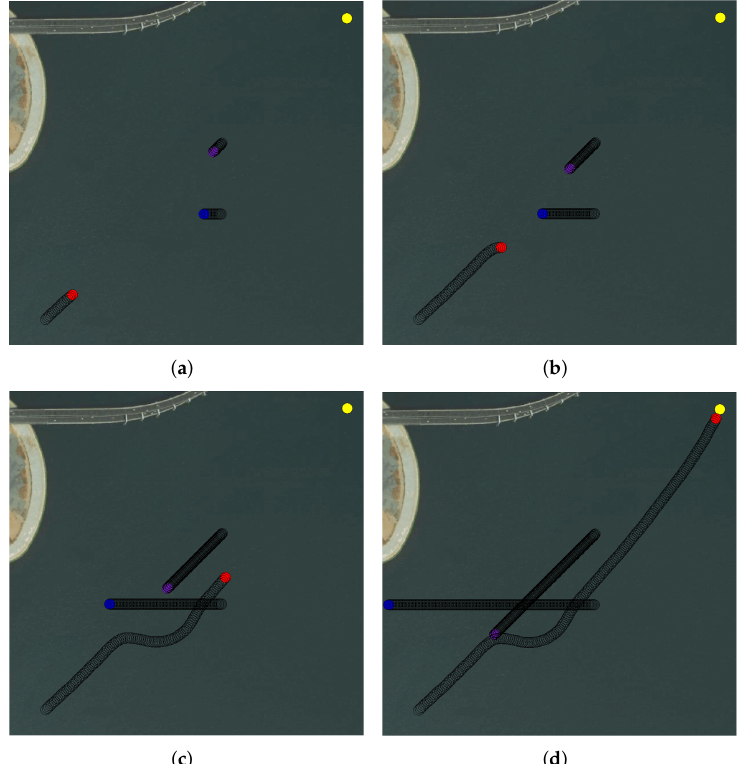
Figure 21. Multi-USV collision avoidance Simulation Environment 1. ( a ) Stage 1. ( b ) Stage 2. ( c ) Stage 3. ( d ) Stage